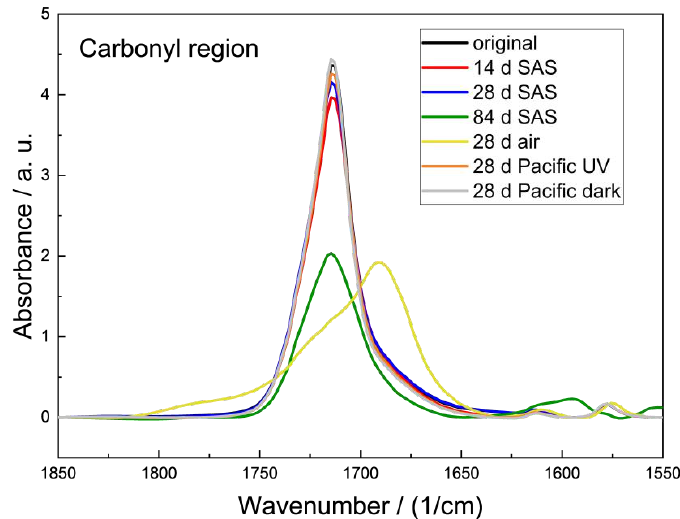
Figure 4. Comparison of the carbonyl regions in the Fourier transform infrared (FTIR) spectra of differently weathered PET sheet samples (colored lines) with the original sample (black line). The main maximum decreases due to weathering. The strongest alteration shows the air-weathered sample with a widening of the band and a shift in the main maximum (yellow).